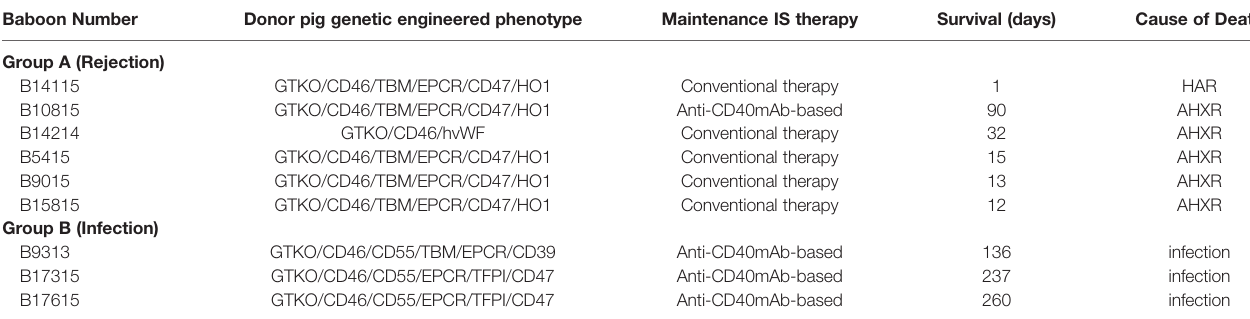
TABLE 1 | Pig genetic engineering, immunosuppressive therapy, recipient survival, and causes of death with tocilizumab treatment. Baboon